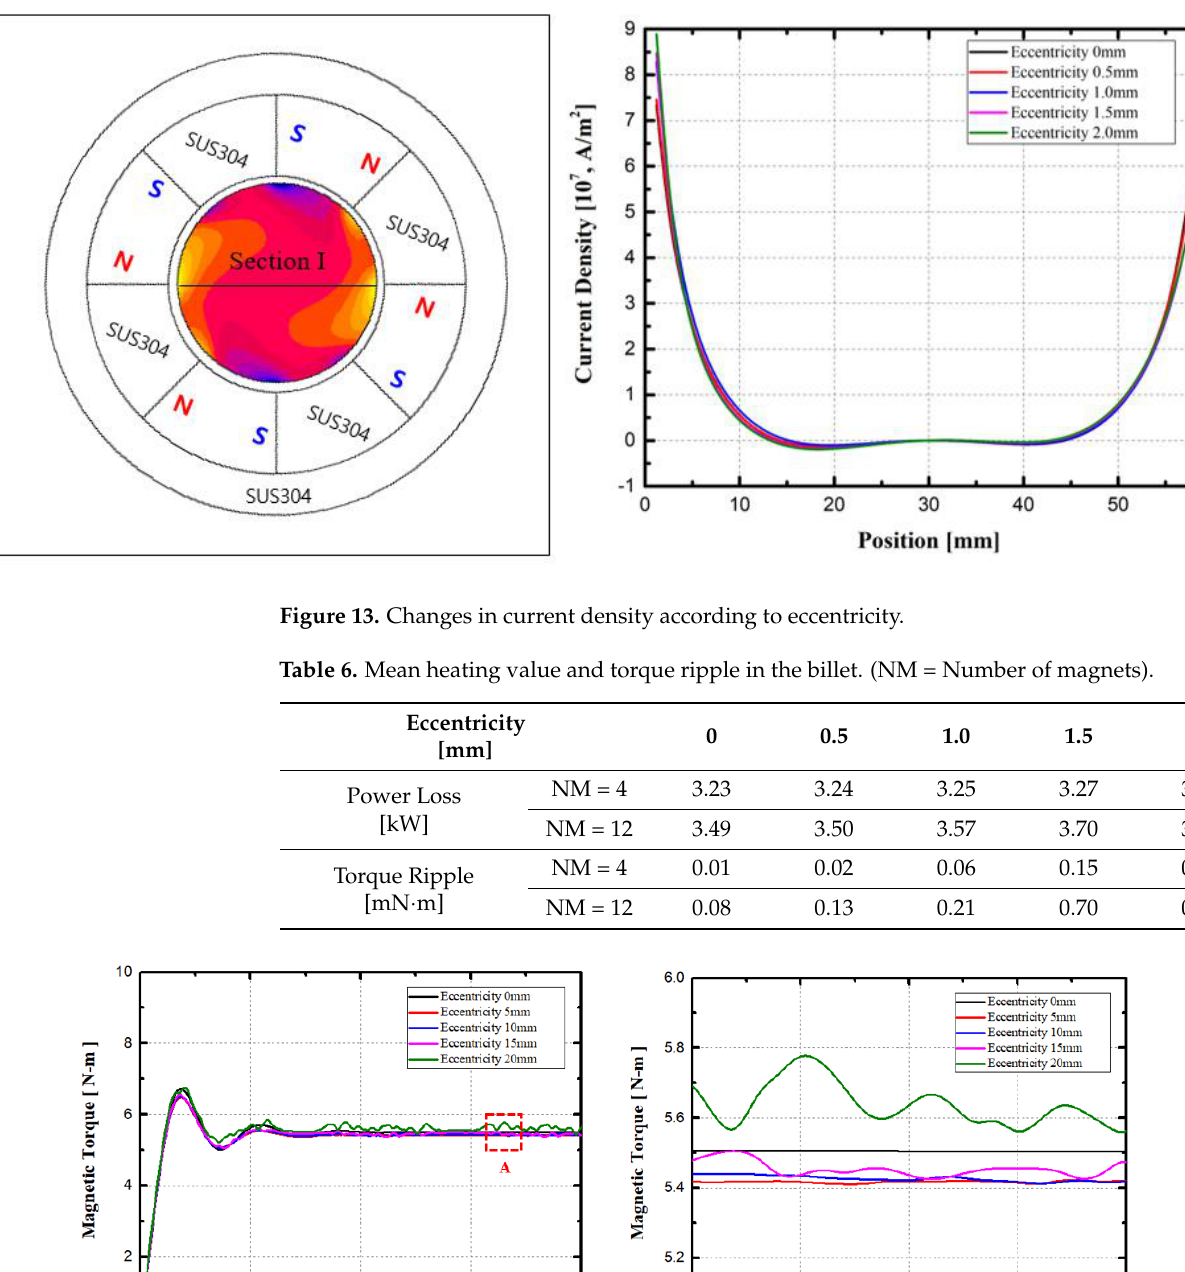
Figure 14. Changes in torque ripple according to eccentricity. Table 6. Mean heating value and torque ripple in the billet. (NM = Number of magnets).